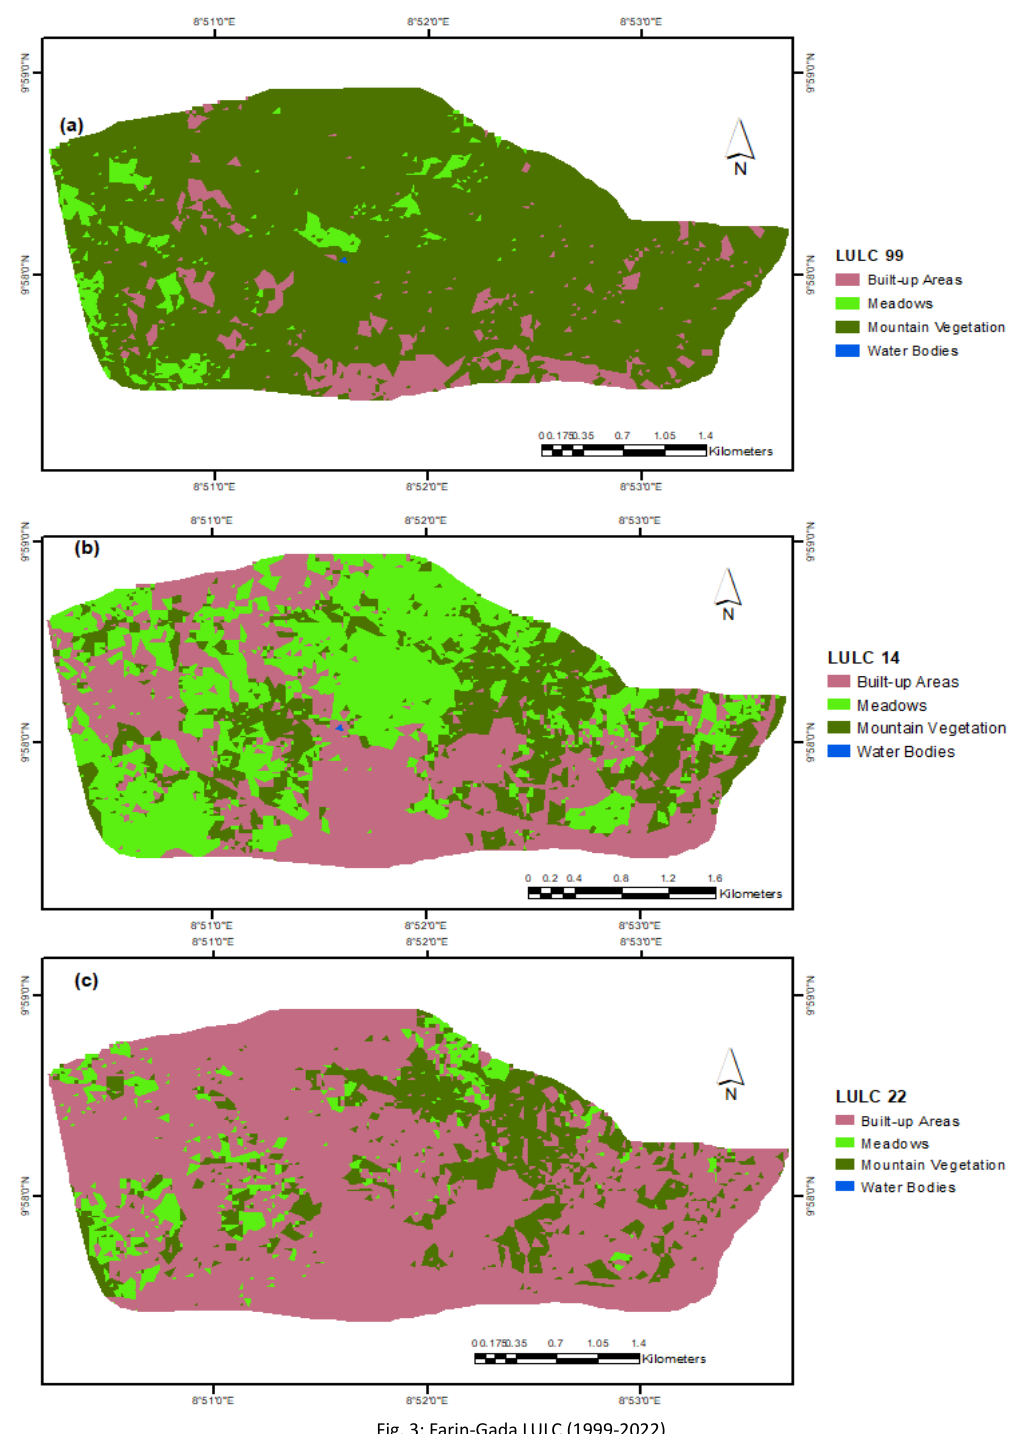
Fig. 3: Farin-Gada LULC Fig. 3: Farin‐Gada LULC (1999‐2022)